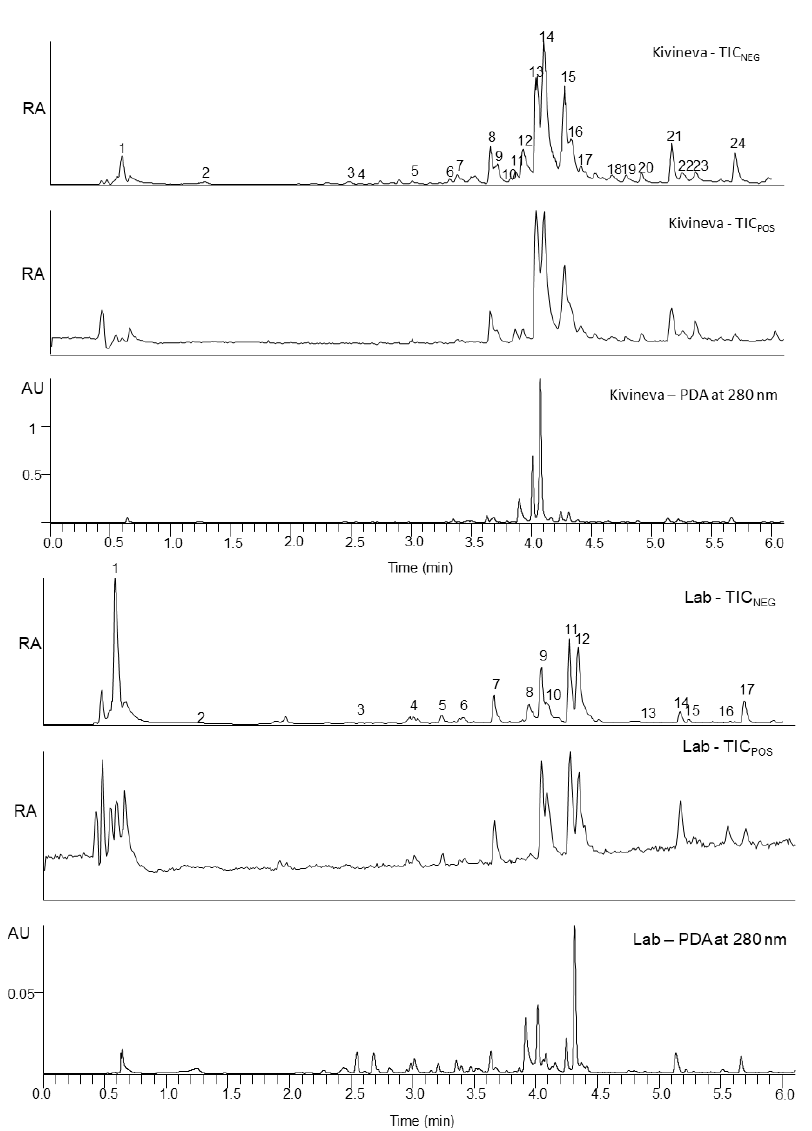
Figure 6. The total ion chromatograms (TIC) in positive and negative ionization and photodiode array (PDA) chromatogram at 280 nm for field-grown sundew (Kivineva mire) on the top and lab-grown propagated sundew (Lab) on the bottom.